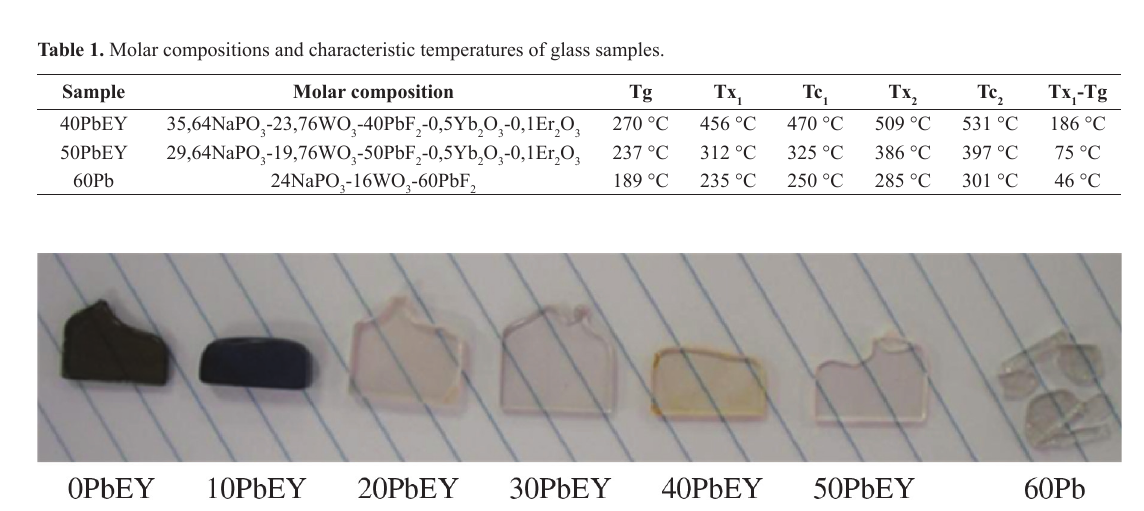
Figure 1. Glass samples obtained in the ternary system NaPO